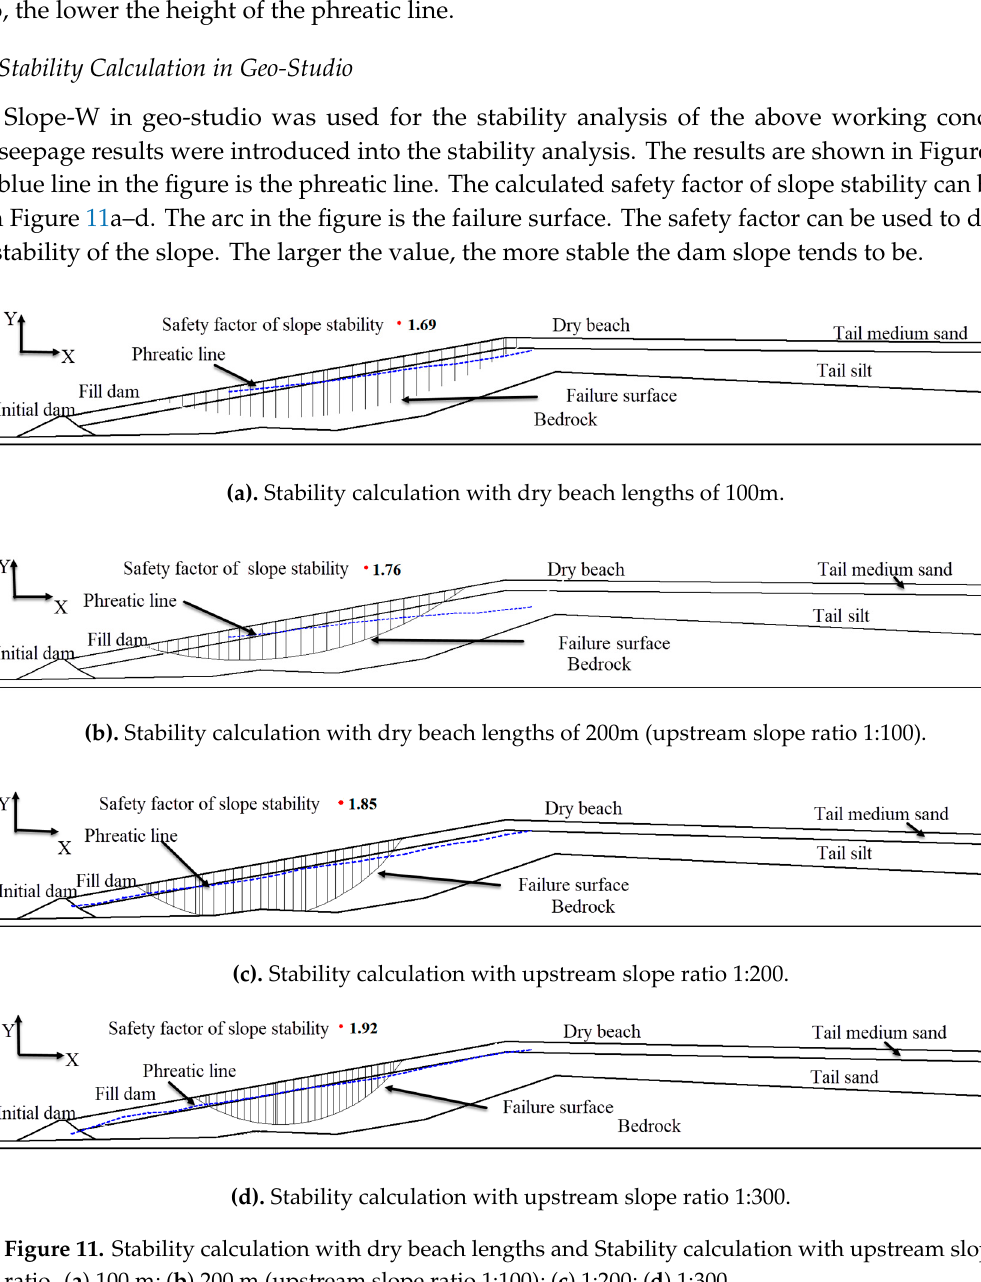
Figure 10. The position of phreatic line under different upstream slope ratios.